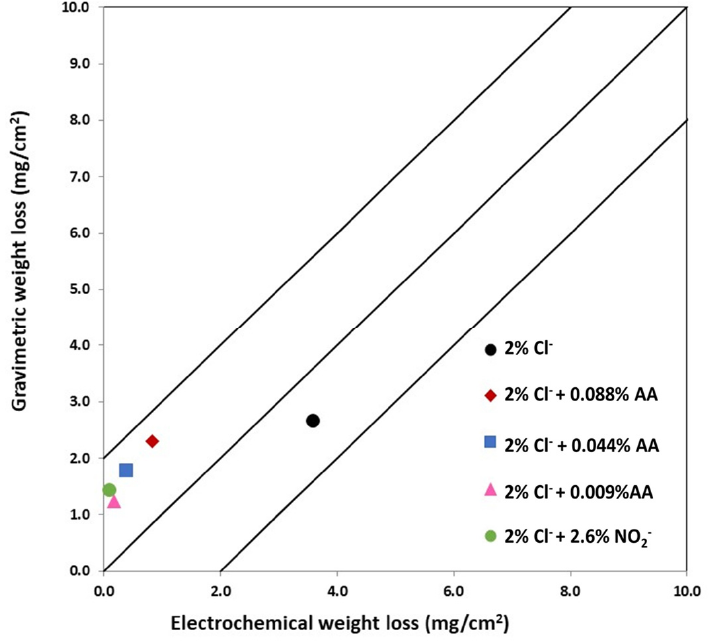
Figure 4. Gravimetric weight loss vs. electrochemical weight loss for chloride-contaminated mortars with inhibitors.